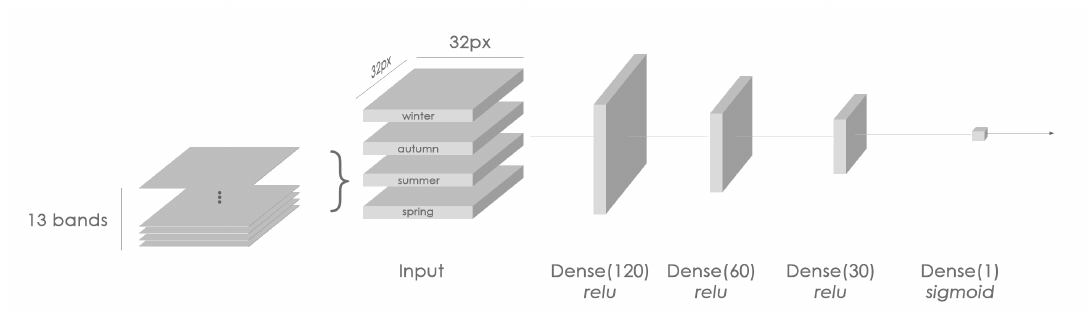
Figure 3. Visualization of the data-set and the model architecture. Dense layers consist of a number (in brackets) of artificial neurons that are fully connected to the adjoining layers. “Relu” refers to rectified linear units and “sigmoid” refers to units that have a sigmoidal activation function.